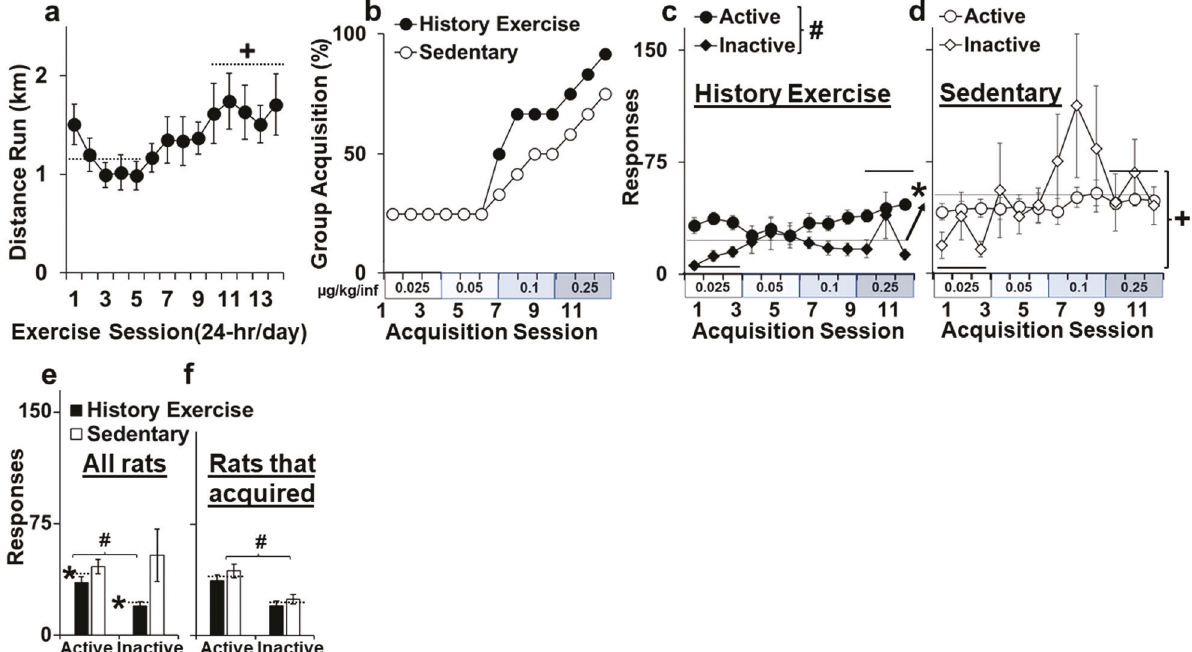
Fig. 2 Effects of discontinued high-access exercise on acquisition of fentanyl self-administration. Average (± SEM) daily distance run in km for the history of exercise group ( a ) and percent group acquisition ( b ) and average (± SEM) active and inactive lever responses in the history of exercise ( c ) and sedentary ( d ) groups as a function of fentanyl dose/acquisition session (0.025, 0.05, 0.1, and 0.25 µg/kg/infusions for sessions 1 – 3, 4 – 6, 7 – 9, and 10 – 13, respectively). Average (± SEM) number of active- and inactive-lever responses across the acquisition testing period for all rats in the acquisition study ( e ) and just the rats that acquired fentanyl self-administration within the 12 – 13-day testing period ( f ). *Signi fi cant effect of group (P ’ s < 0.05; b – d ); # Signi fi cant effect of lever (P ’ s < 0.05; b , e , d -history of exercise); + Signi fi cant difference between sessions 1 – 3 and 10 – 12 ( P < 0.05; b , c